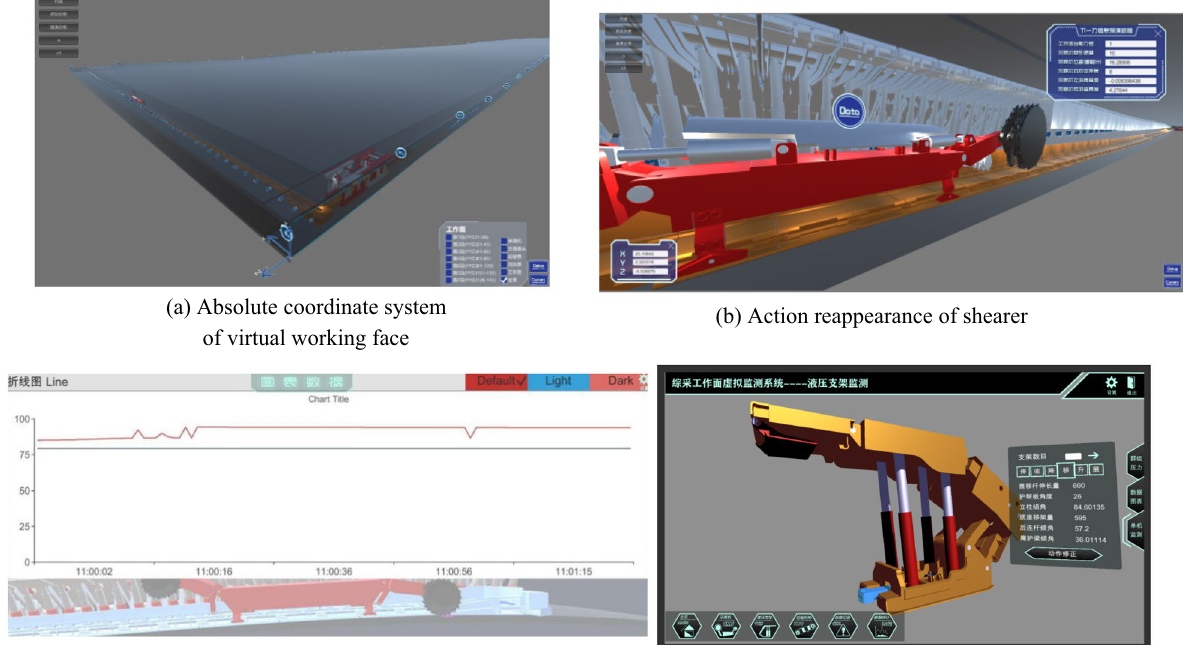
Fig. 11 Initial scenario construction and offline simulation